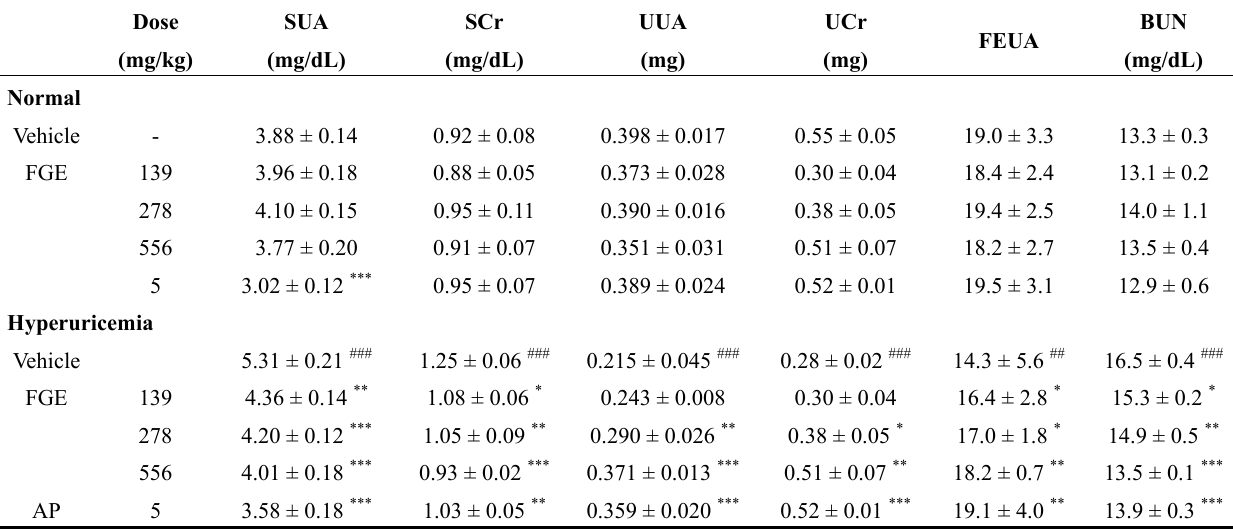
Table 1. Effects of FGE and allopurinol (AP) on serum uric acid levels (SUA), serum creatinine levels (SCr), excretion of uric acid (UUA) in 24 h, excretion of creatinine (UCr) in 24 h, fractional excretion of uric acid (FEUA) and blood urea nitrogen (BUN) concentrations in hyperuricemic and normal mice.